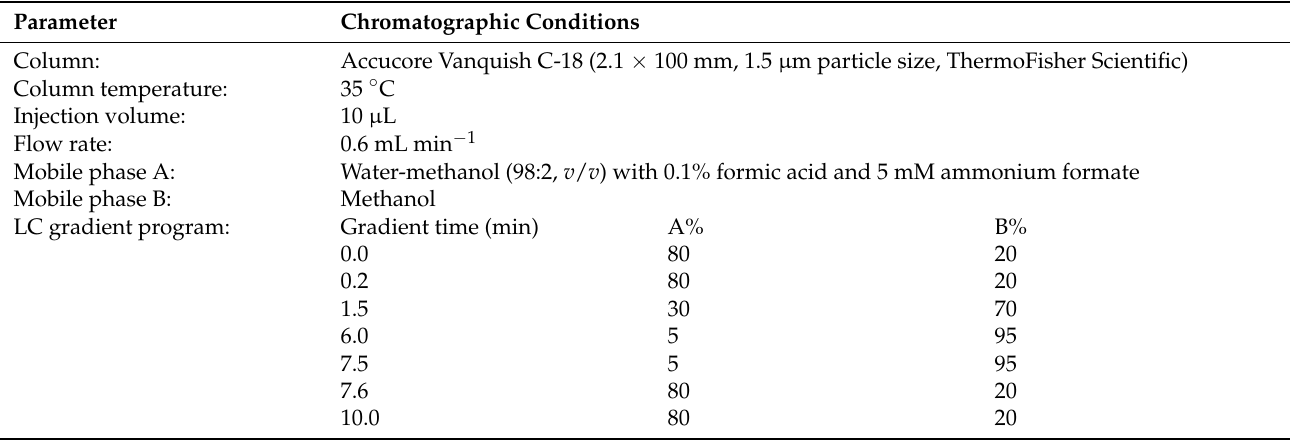
Table 1. Analytical conditions for